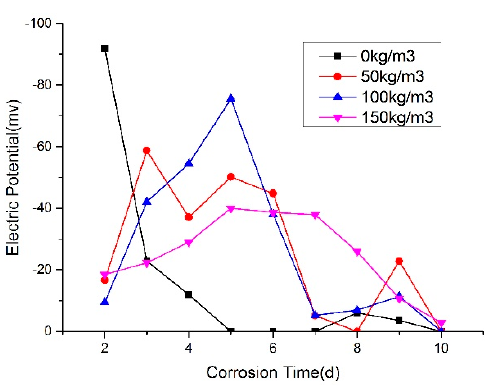
Figure 11. Potential value of W/C = 0.55.